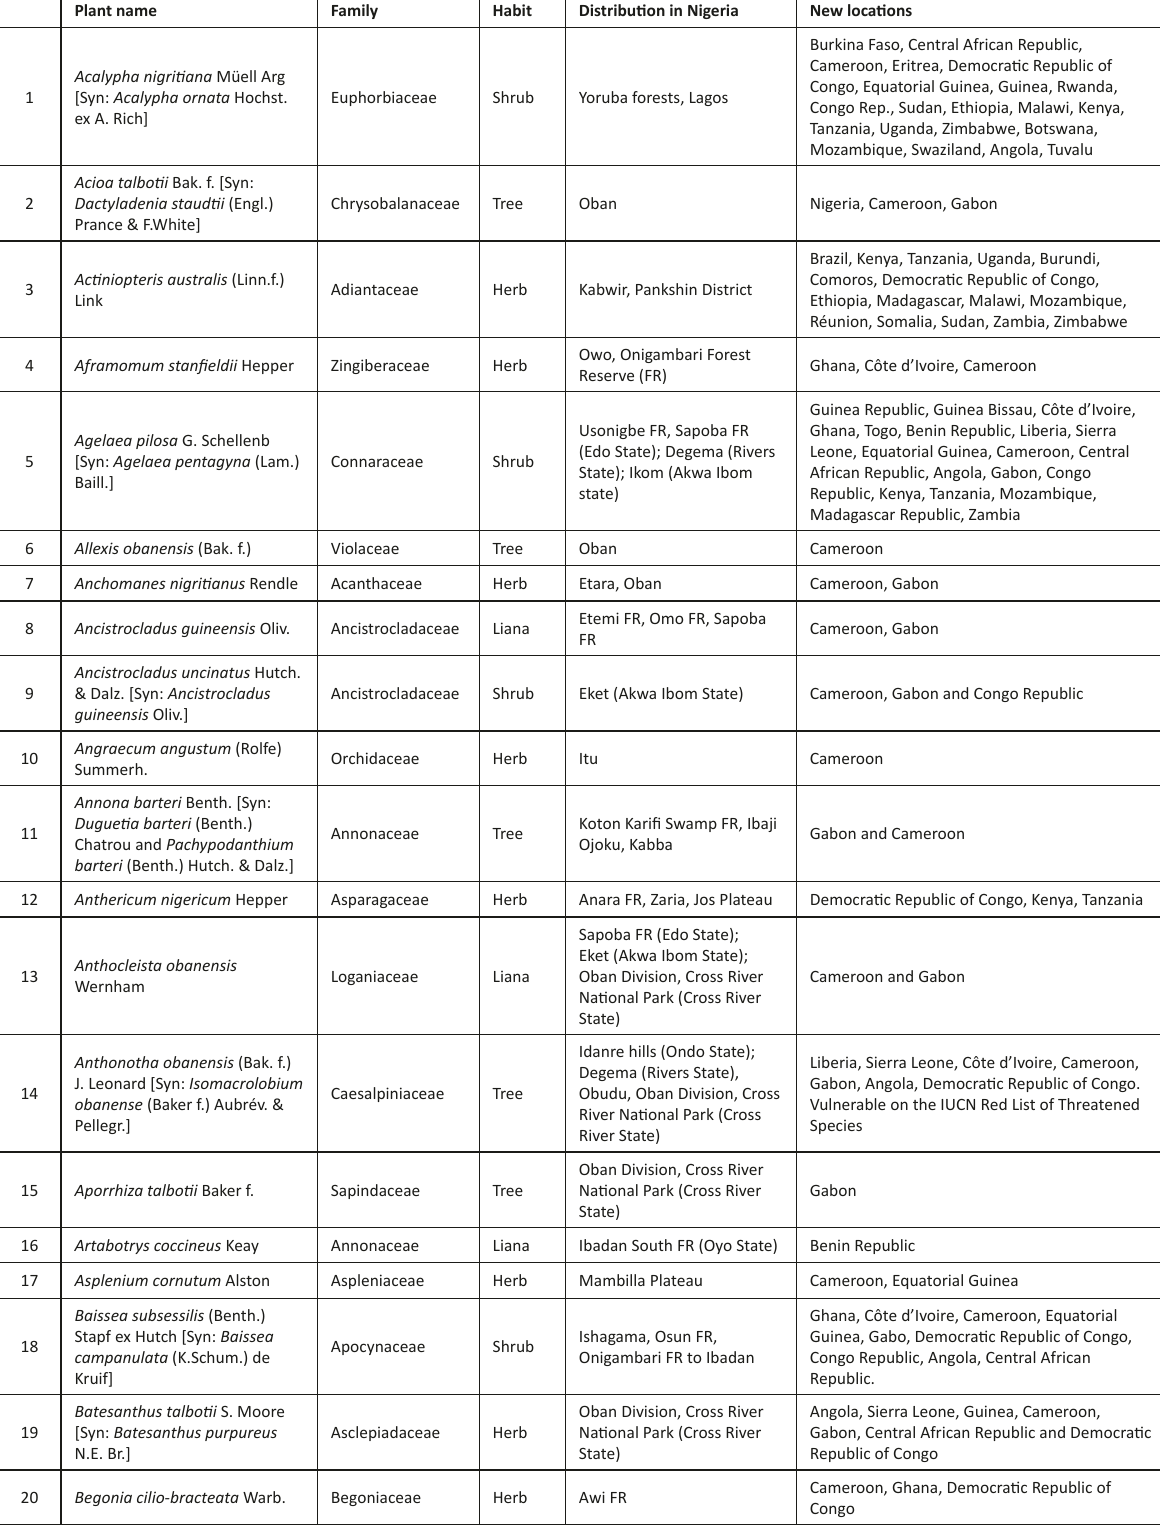
Table 2. List of previously thought endemic species in